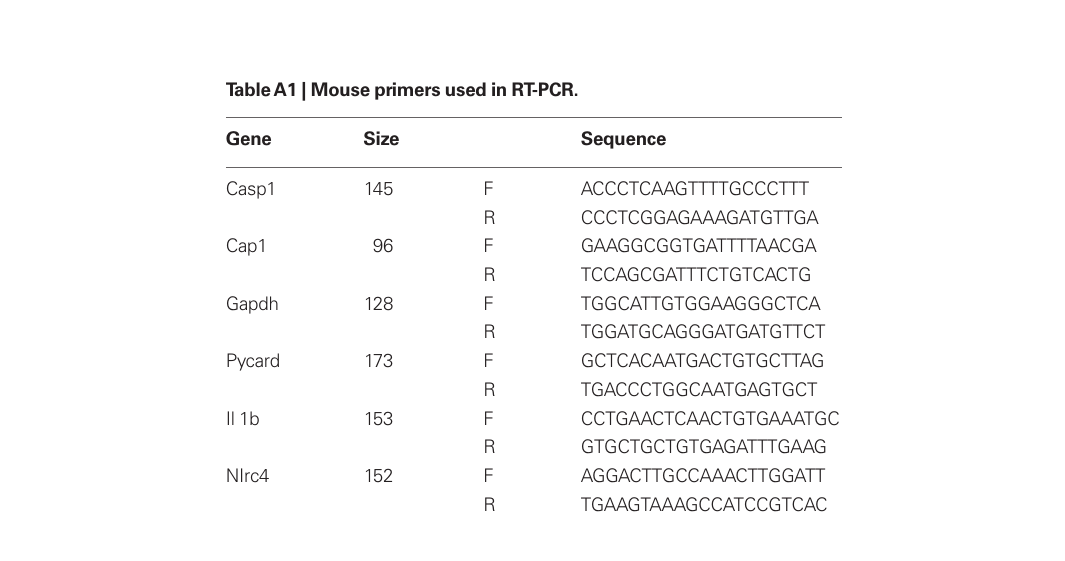
Figure A2 | Legionella pneumophila differentially regulates the expression of several components of the inflammasome. WT mouse macrophages were infected or not (NT) with Legionella pneumophila (Leg) at MOI = 0.5 for 4 and 24 h. then the expressions of (A) pro-caspase-1, (B) pro-Il-1 β , (C) Pycard (Asc), and (D)